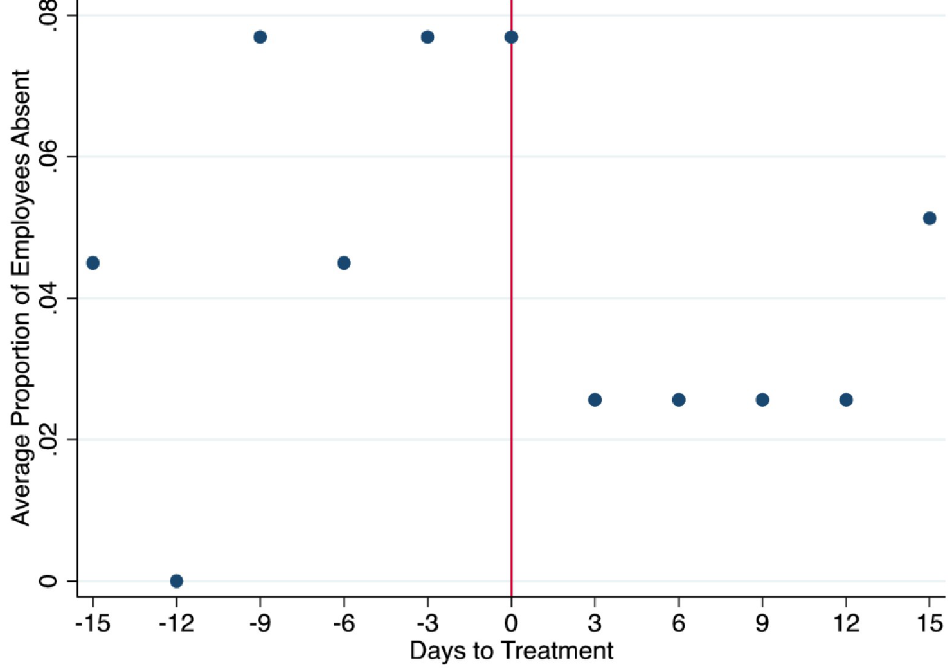
Fig 3. Ex post and ex ante proportion of employees absent.